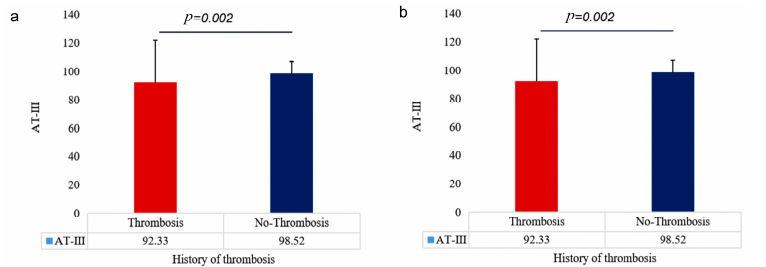
Figure 7. Differences in coagulation factor levels between patients with and without a history of thrombosis. ( a ) AT-III expression varies across patients with and without a history of thrombosis, ( b ) differences in Fbg expression in patients with and without thrombotic history.